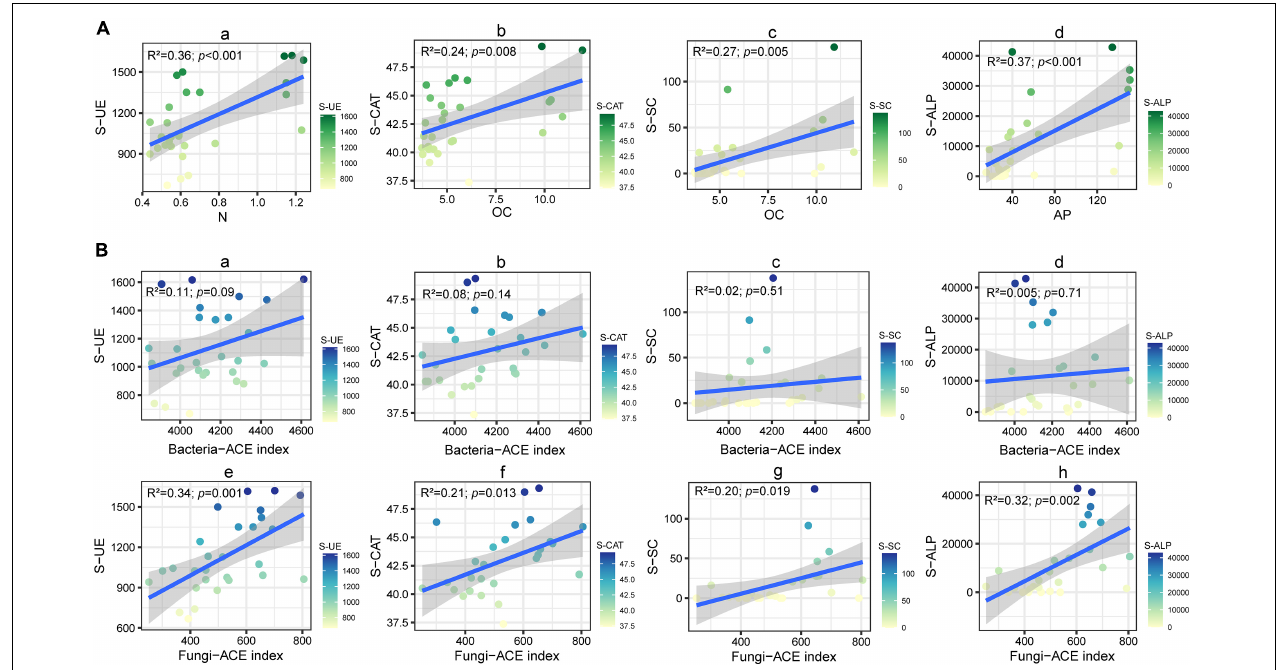
FIGURE 9 | Linear fitting analysis of soil enzyme activity and soil physical and chemical properties (Aa–Ad) and microbial community richness index (Ba–Bh) . R 2 represented the magnitude of the correlation coefficient, and the p -value was generated by a t